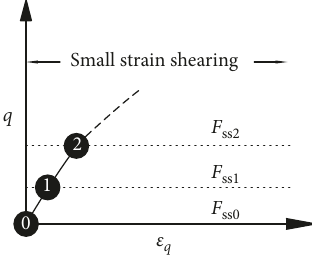
Figure 1: Schematic of small strain yield surface and its move- denotes small strain yield surface position at point i , ments. F ss i where i � 0, 1, and 2.